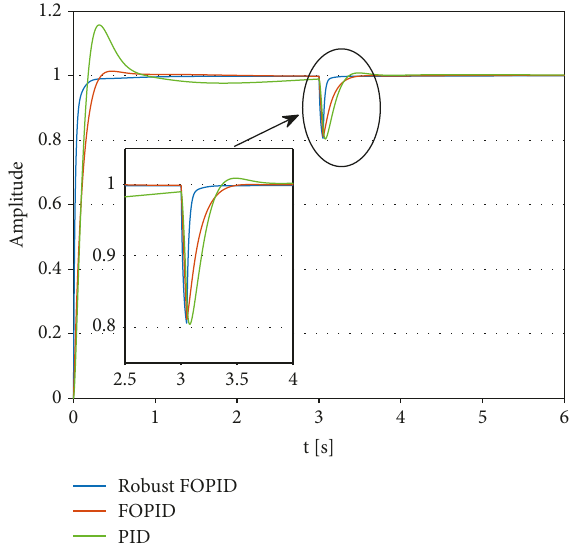
Figure 14: Step response comparison of G